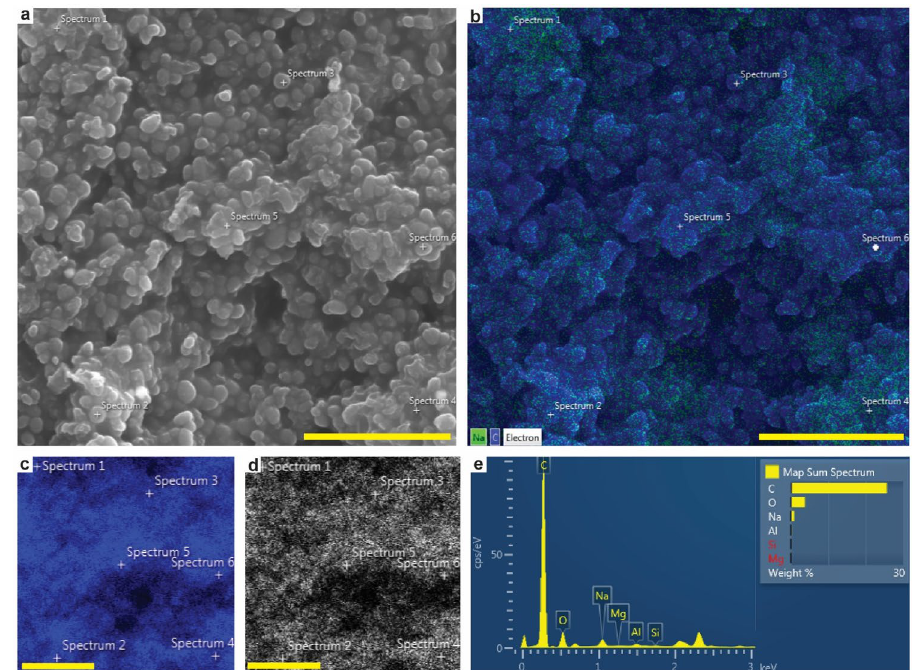
Figure 4. Energy dispersive X-ray microanalysis of HF demineralized fossil flipper tissue. ( a ) FEG-SEM micrograph showing abundant melanosomes. ( b ) EDS map of carbon (blue) and sodium (green) superimposed on the SEM micrograph depicted in ( a ). ( c , d ) Individual elemental maps of carbon ( c , blue) and oxygen ( d , white). ( e ) Averaged spectrum of six independent single-spot EDS measurements. Scale bars, 5 μm ( a – d